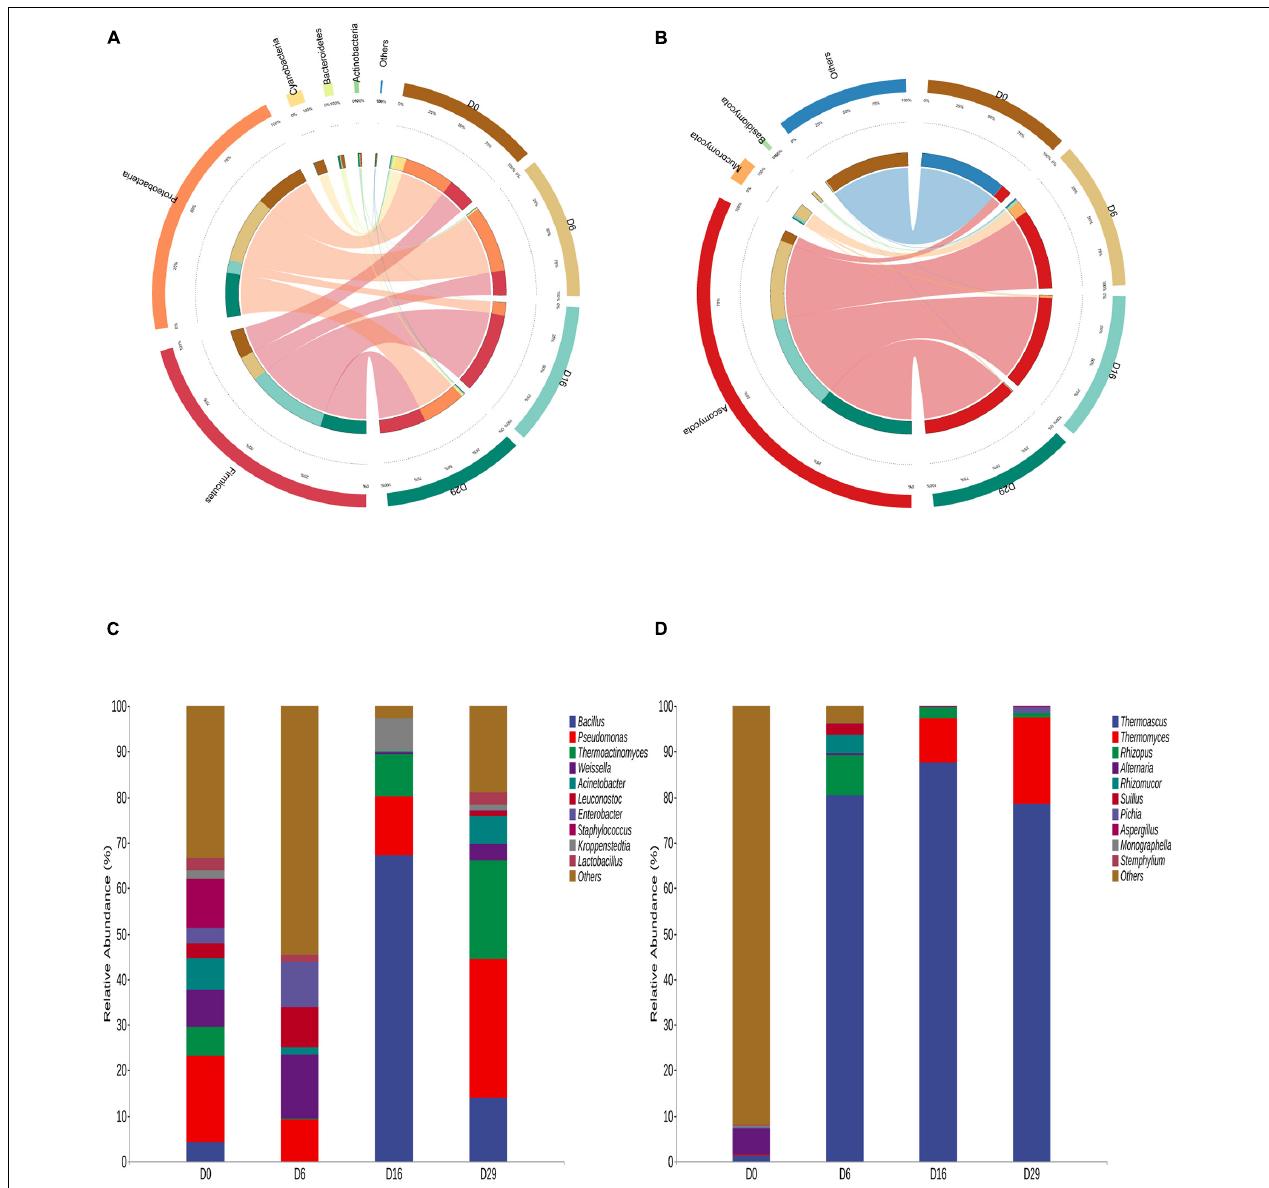
FIGURE 2 | Distribution of bacteria (A) and the fungi (B) on phylum level during the fermentation process of Daqu. And showing the changes of major bacteria (C) and fungi (D) in the samples during the fermentation on genus level.